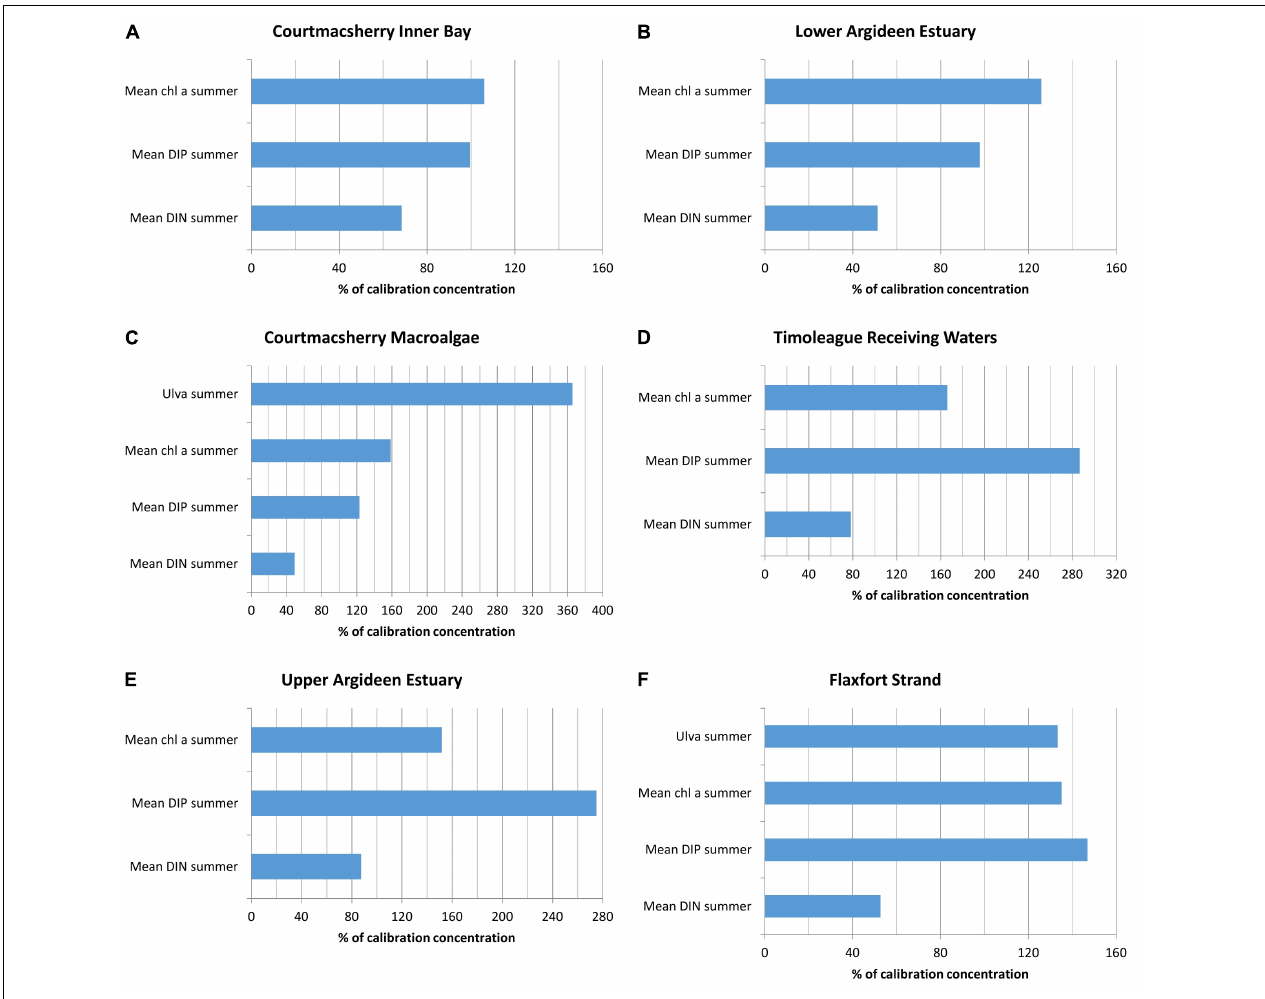
FIGURE 8 | Percentage change in N, P, chlorophyll a and macroalgae due to imposition of flow load relations for 2010 to 2016 flow data in (A) Courtmacsherry Inner Bay, (B) the Lower Argideen Estuary, (C) the Courtmacsherry macroalgae zone, (D) the Timoleague Receiving Waters, (E) the Upper Argideen Estuary, and (F) Flaxfort